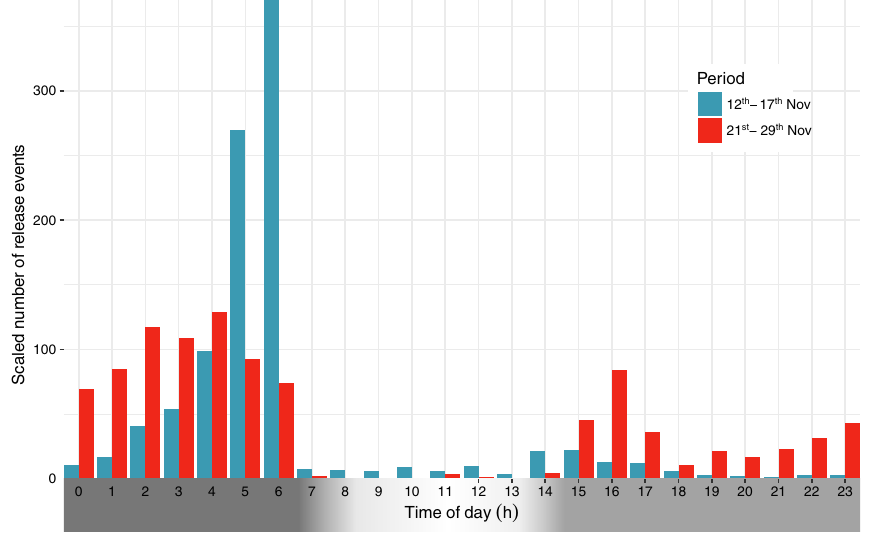
Figure 2. Diel patterns in gas release as represented by the hourly records averaged for two registration periods. Patterns of shading of x-axis refers to darkness and daylight.